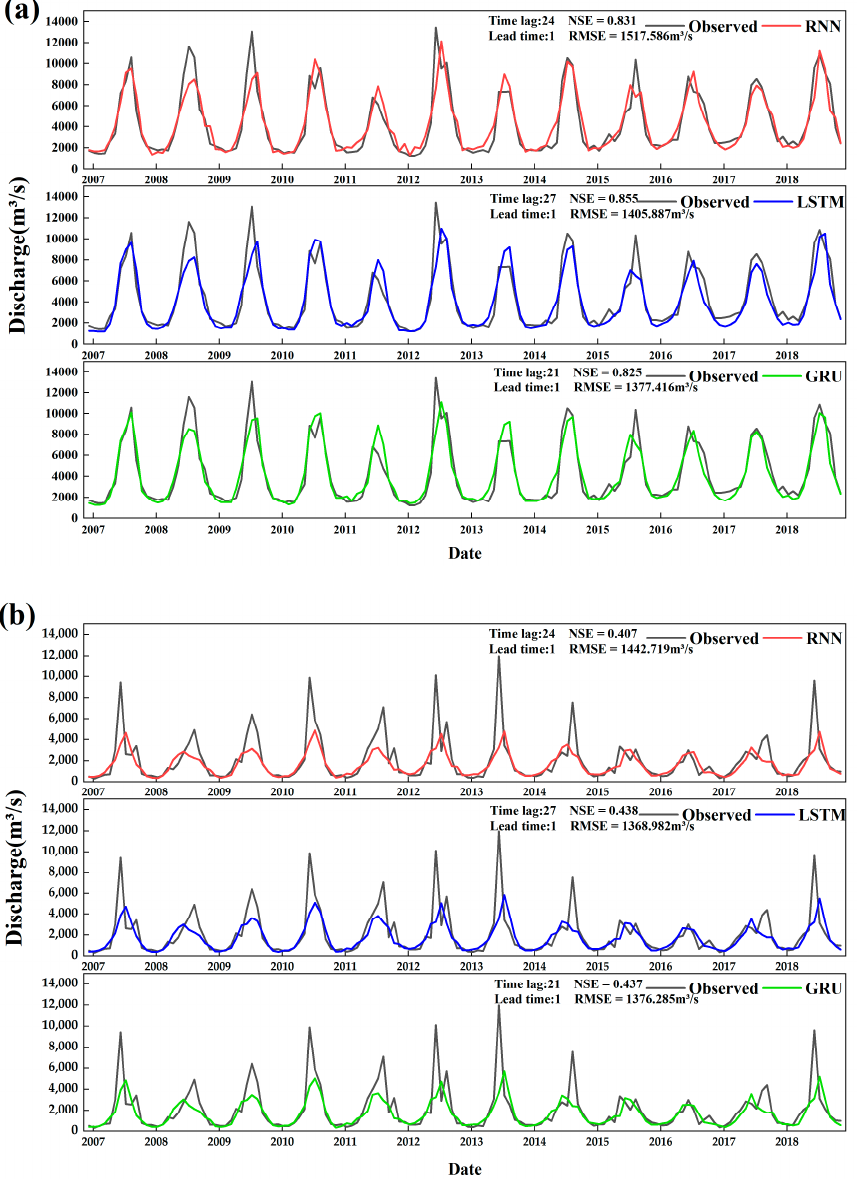
Figure 13. Observed and predicted discharge from RNN, LSTM, and GRU models at optimal time lag and lead time at monthly scale in ( a ) Pingshan and ( b ) Beibei.